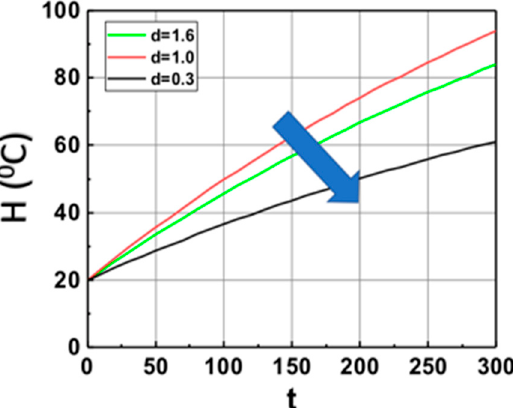
Figure 2. The calculated temperature (at z = 1.0 cm) profiles of monomer based on Equation (15) for various weight concentration of Fe, with aFI 0 = (0.3, 1.0, 1.6) (1/s) and b’ = 0.002 (1/s), in the absence of PI (with b = 0), with heat produced by light absorption of Fe only, with initial temperature H 0 = 20 °C. The arrow indicates the direction of increased values of aFI 0.